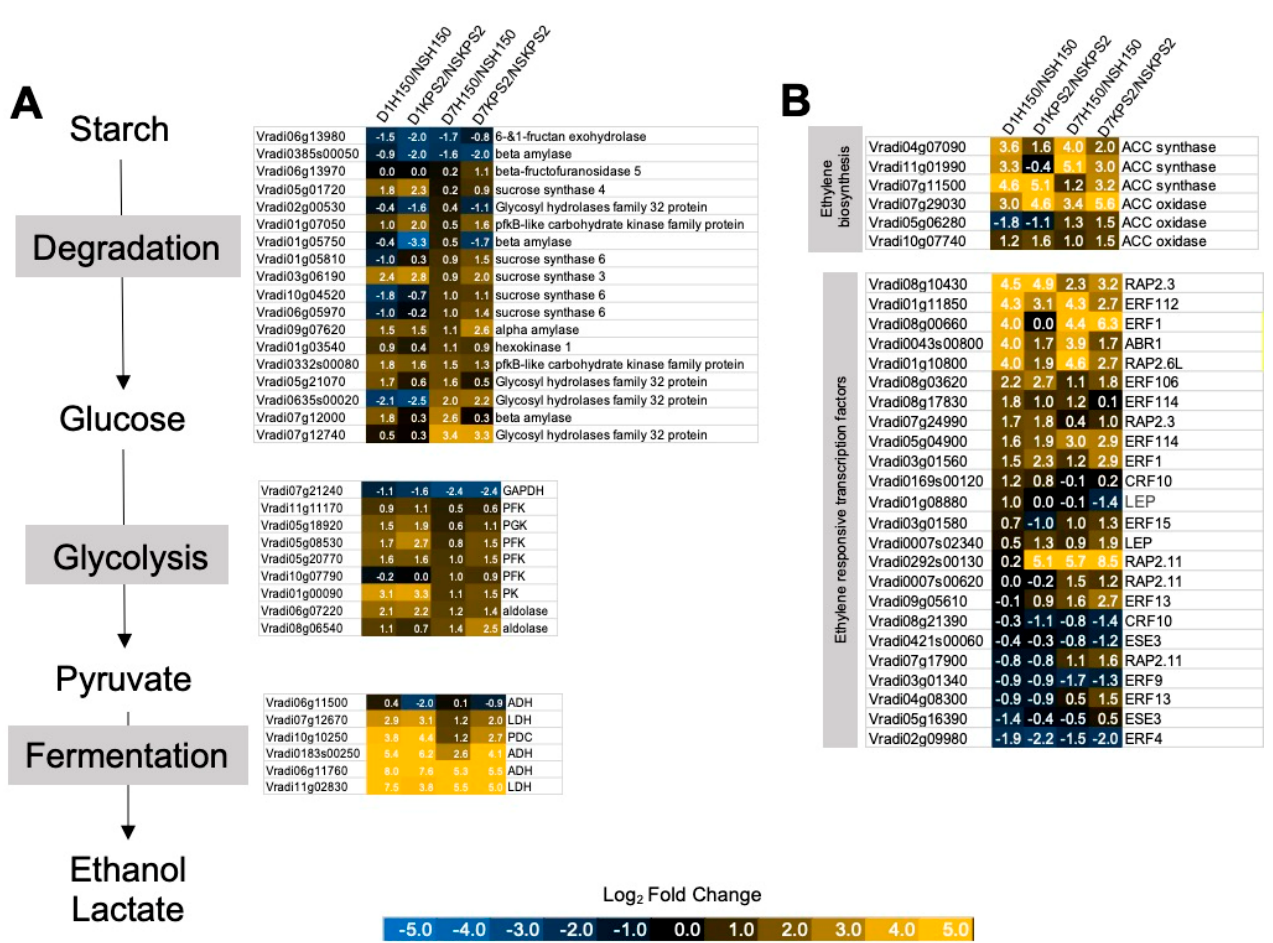
Figure 4. WS resulted in differential expression of transcripts encoding proteins involved in energy and ethylene production. ( A ) major carbohydrate metabolism, glycolysis, fermentation ( B ) ethylene biosynthesis and response. The number indicates log2 fold changes. Data can be found in Table S2.